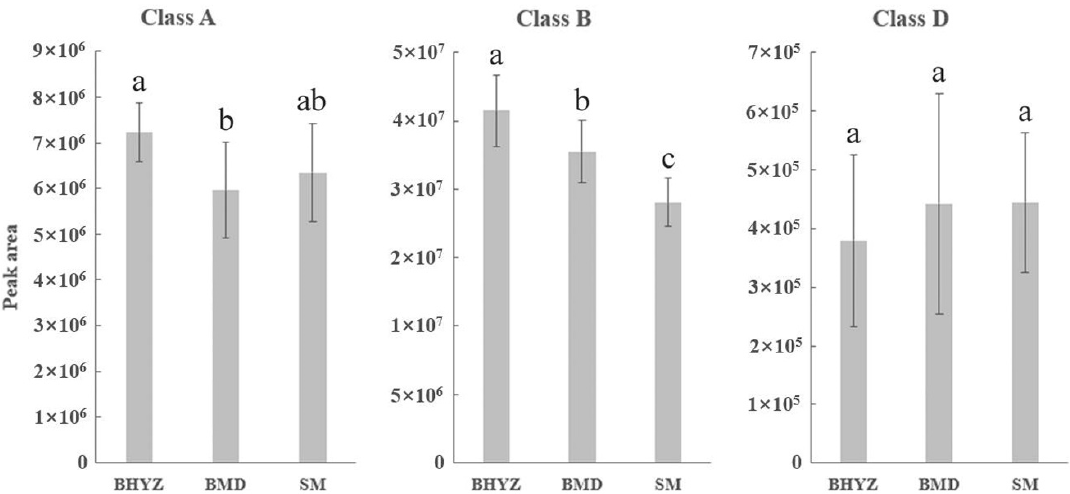
Figure 5. Comparison of total peak area of the 25 identified odorants in different odor classes among BHYZ, BMD, and SM. Note: different letters (a, b, ab, c) above the histograms represent the statistic difference ( p < 0.05) among different groups.